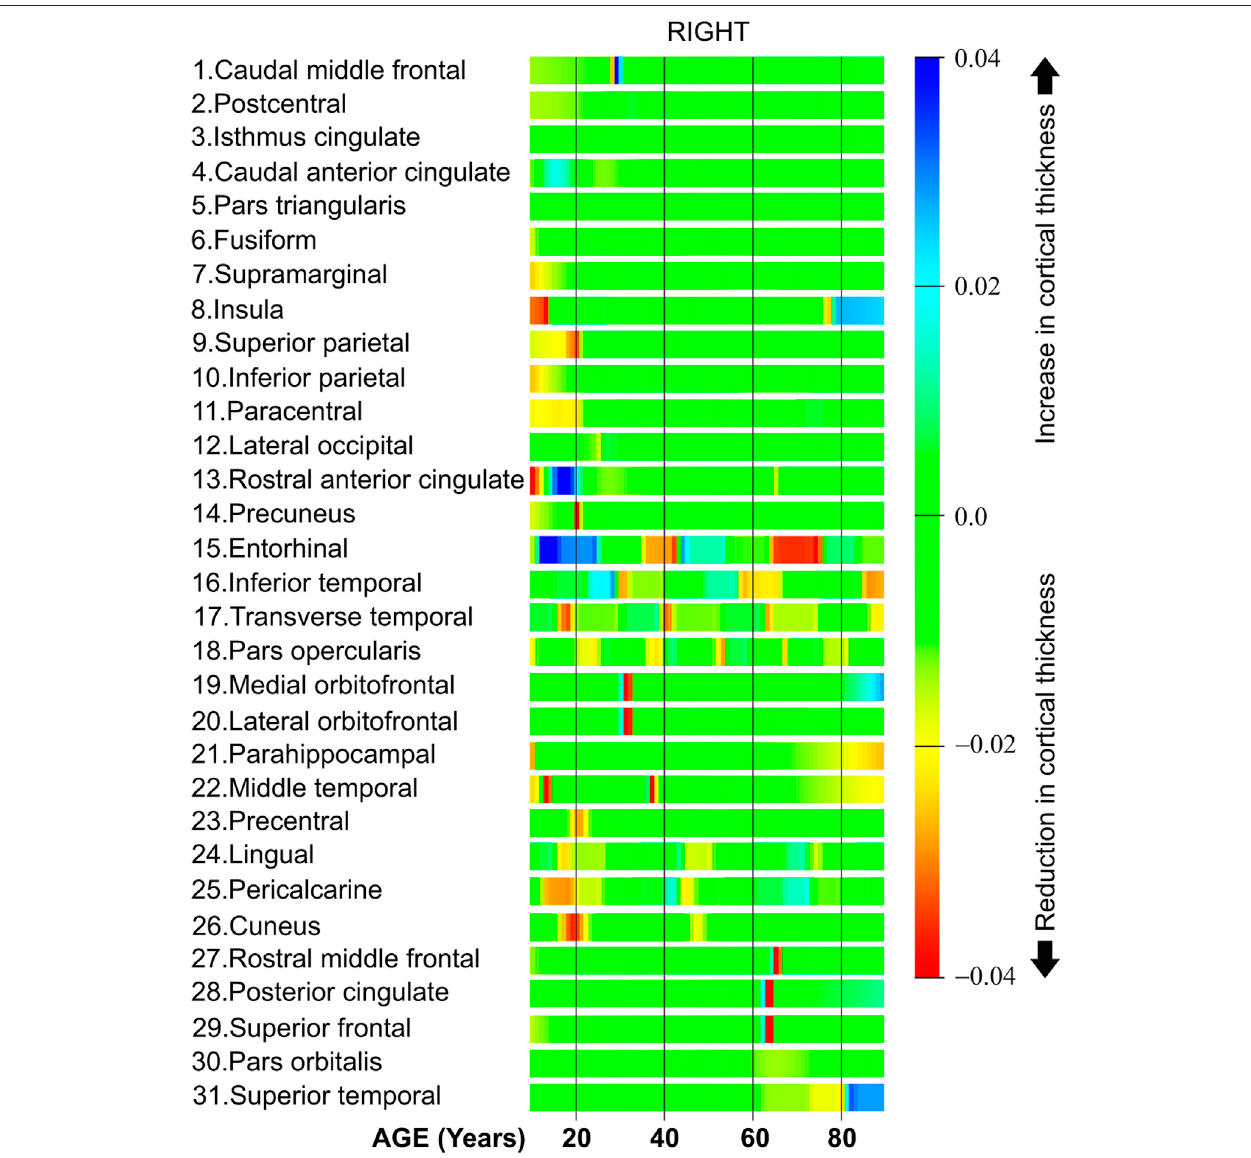
FIGURE 9 | Cortical thickness derivative with respect to age, right